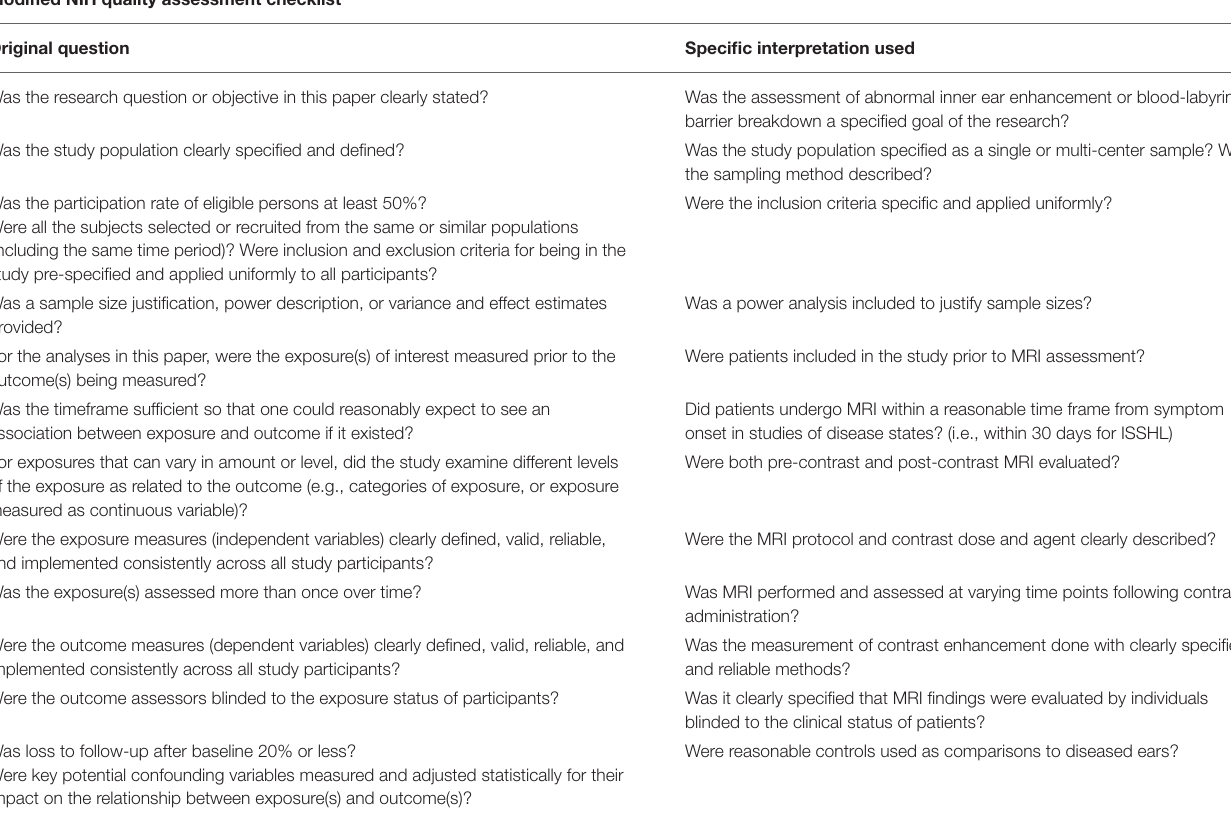
TABLE 1 | Modifications made to the NIH quality assessment